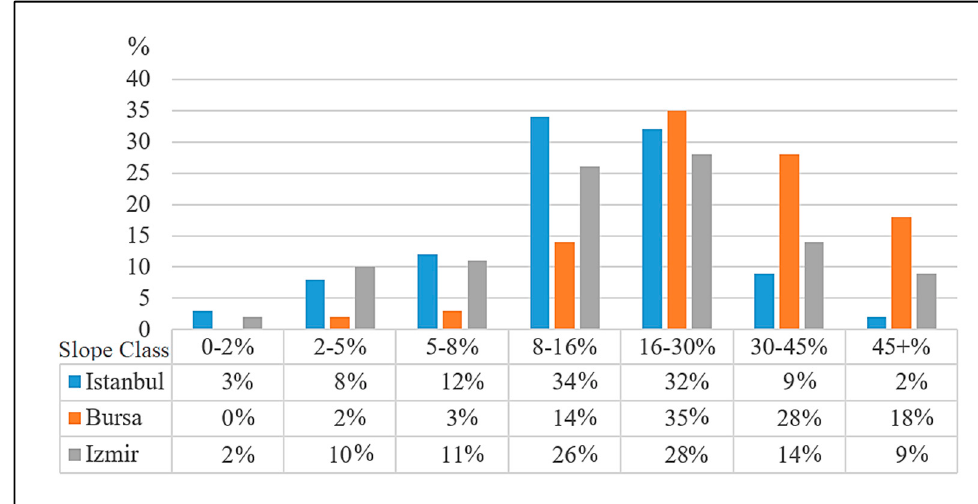
Figure 2. Topographic characteristics of the study regions.